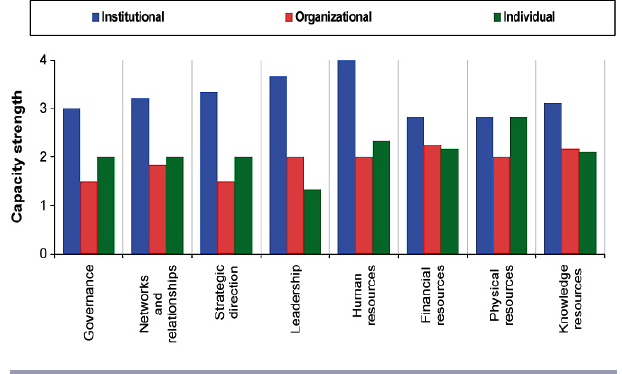
Fig. 2. Institutional tier’s capacity as perceived by three community tiers (mock